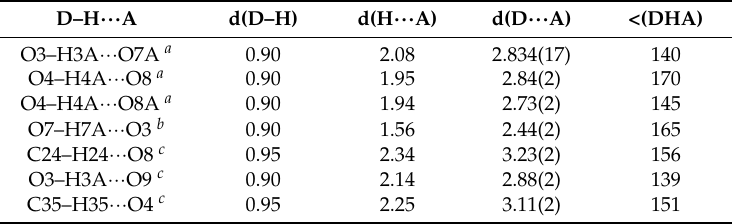
Symmetry transformations used to generate equivalent atoms: a − x +2, − y +1, − z +2; b x − 1, y , z ; c − x +1, − y +1, − z +2; D—proton donor; A—proton